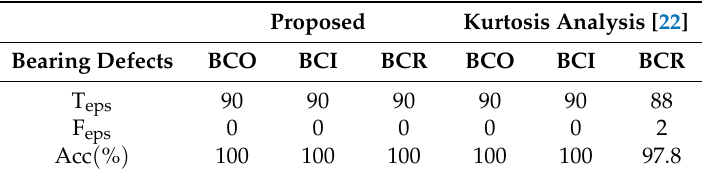
Table 5. The accuracy of bearing defect detection with 500